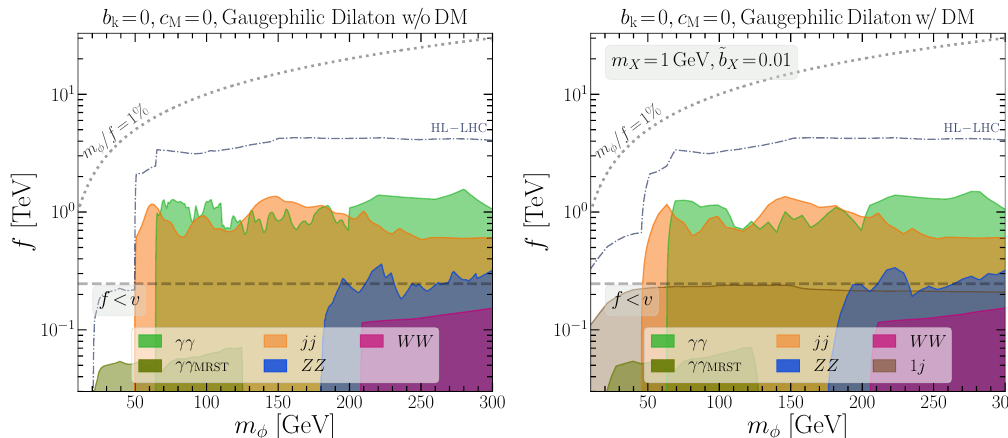
Figure 7 . Exclusion bound on the gauge-philic dilaton parameter space in the m (cid:30) the collider reach in such region for illustrative purpose in order to highlight the signi(cid:12)cant opportunity for improvements in experimental coverage of such scenario. We conclude by observing that in this simpli(cid:12)ed gauge-philic scenario there is a large portion of parameter space with dilaton mass m =f > 1% which is still viable and that could be (at least (cid:30) partially) covered at